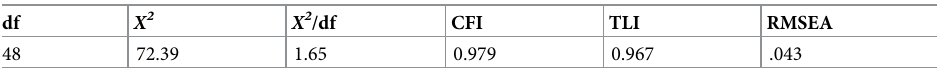
Beliefs about donation. A Confirmatory Factor Analysis using maximum likelihood esti- mation procedures was performed on all responses to the 12 items measuring beliefs about organ donation. A four-factor model offered the most parsimonious fit for the data (Tables 2 & 3). Overall, participants strongly agreed with the Gift of Life and Benefits to Self beliefs. Scores relatively low (see Table 4).